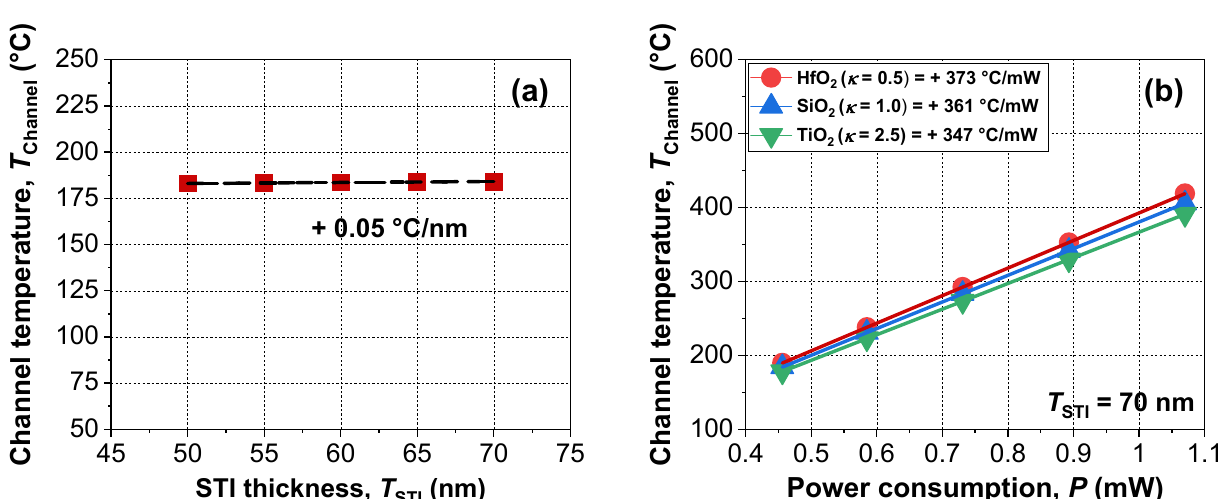
Figure 9. Extracted T Channel of devices with various ( a ) thickness and ( b ) materials of shallow trench isolation (STI). Dashed lines indicate linear fits of the experimental data.